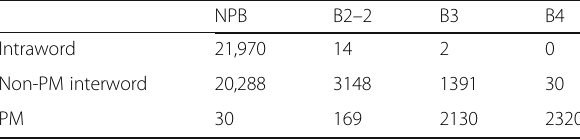
Table 1 Co-occurrence matrix of four target break types and three syllable juncture types